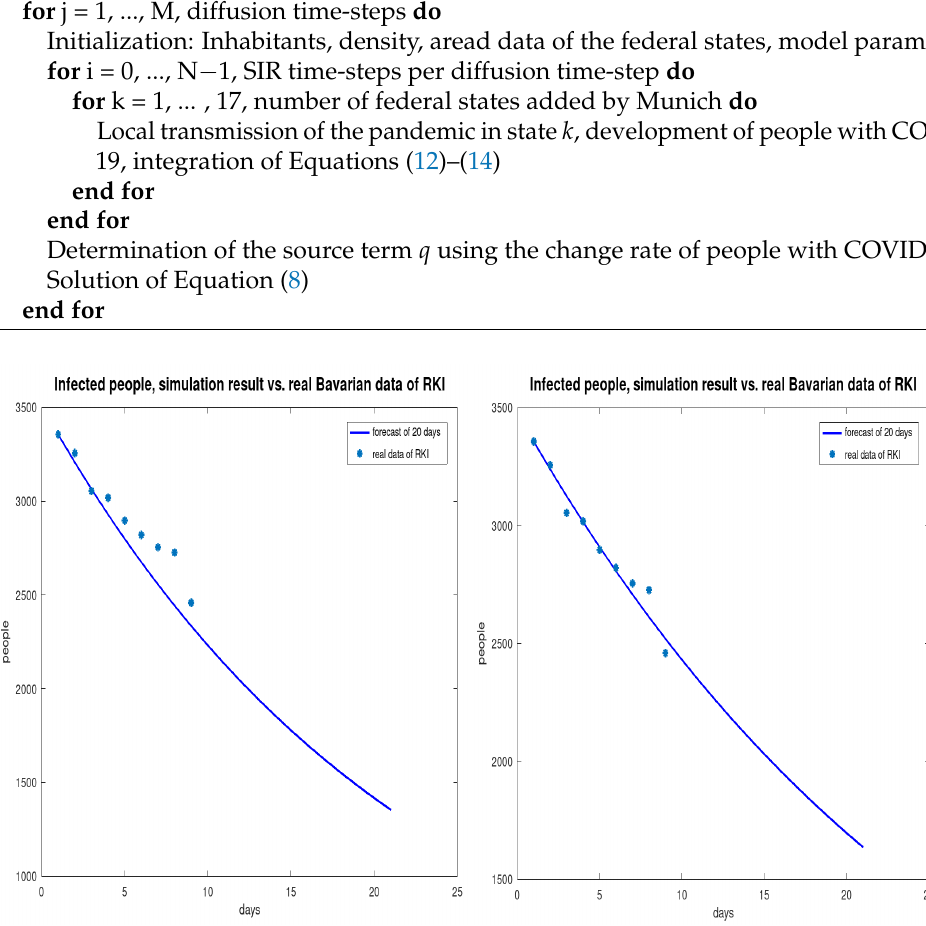
Figure 7. Course of people with COVID-19 in Bavaria, from 26 April 2021 to 5 May, without diffusion ( left panel ) and with diffusion ( right panel ).